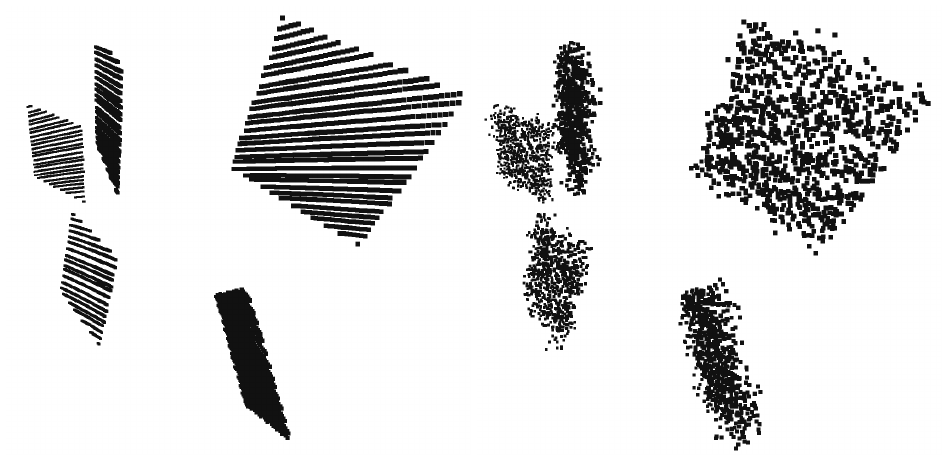
Figure 4. The point cloud of the KITTI virtual calibration scene. Left plot: the virtual Velodyne HDL-64 does not contain noise. Right plot: Gaussian noise added with zero mean and a 0.14 standard deviation.